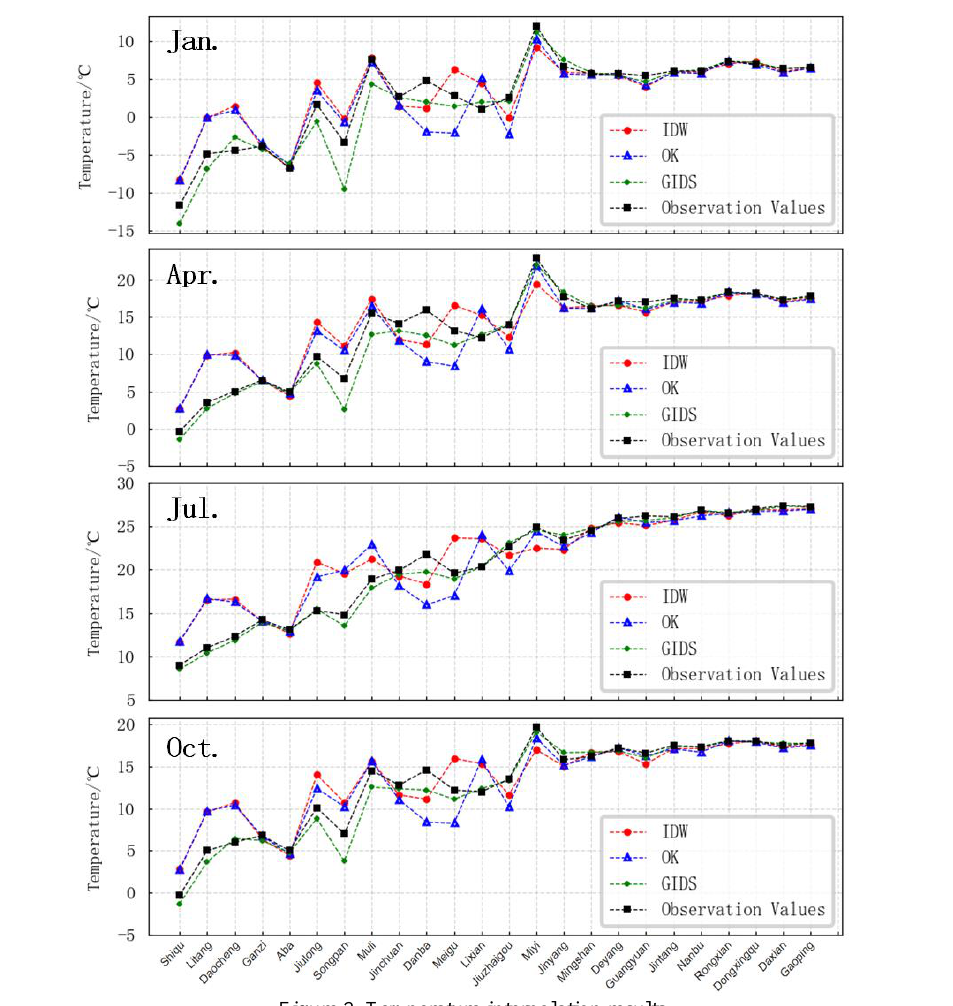
Figure 2. Temperature interpolation results